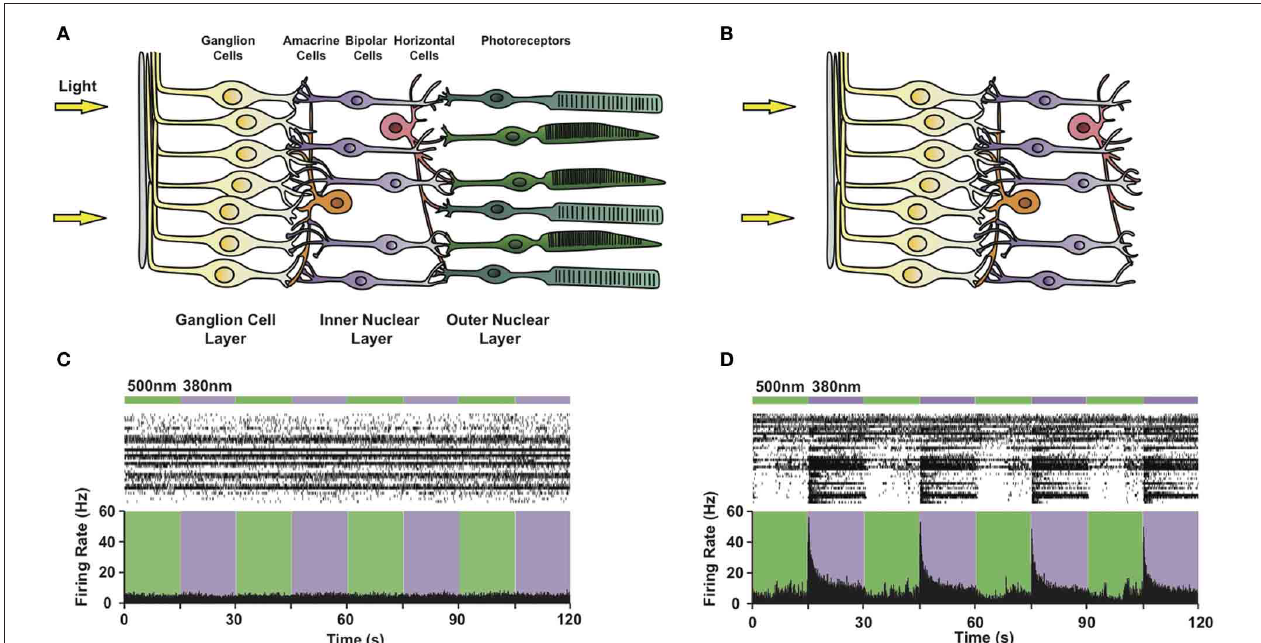
FIGURE 5 | Photosensitizing blind retinas with PCLs. Circuit diagram of (A) a healthy retina and (B) a retina lacking rod and cone photoreceptors due to advanced degeneration. Note that retinal ganglion, bipolar and amacrine cells survive photoreceptor death. (C,D) Multi-electrode array recordings